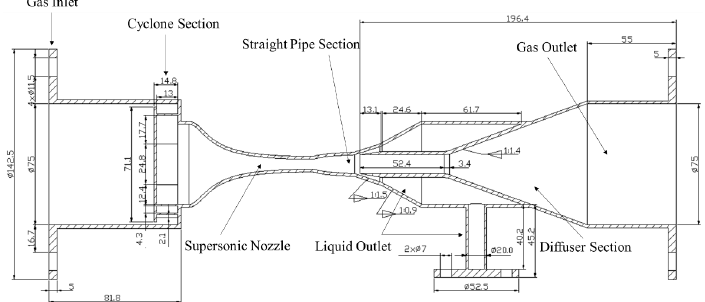
Figure 1. Schematic of the supersonic separator.